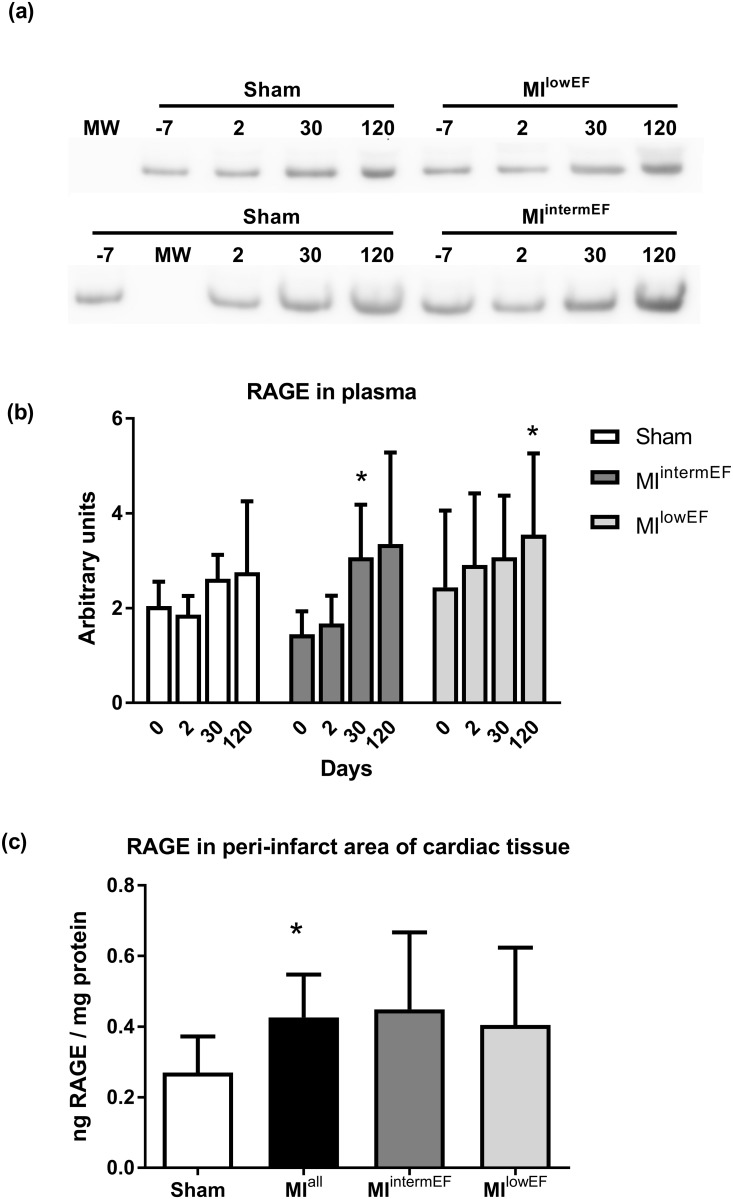
RAGE levels.sRAGE levels in plasma by Western blot (a, b) and RAGE levels in heart homogenate measured by ELISA (c). Representative image showing the signal at 45 kDa (a). Statistical analysis: GEE, data expressed as mean ± SE (* p < 0.01 compared with day zero in the same group); sham group, n = 5; MIintermEF group, n = 5; MIlowEF group, n = 6) (b). ANOVA with Tukey’s test, data expressed as geometric mean ± 95% CI (n = 15; MI group, n = 7 per group). * p = 0.052 compared with sham (c); MIintermEF: EF > 53.7% and < 66.5%; MIlowEF: EF < 53.7.